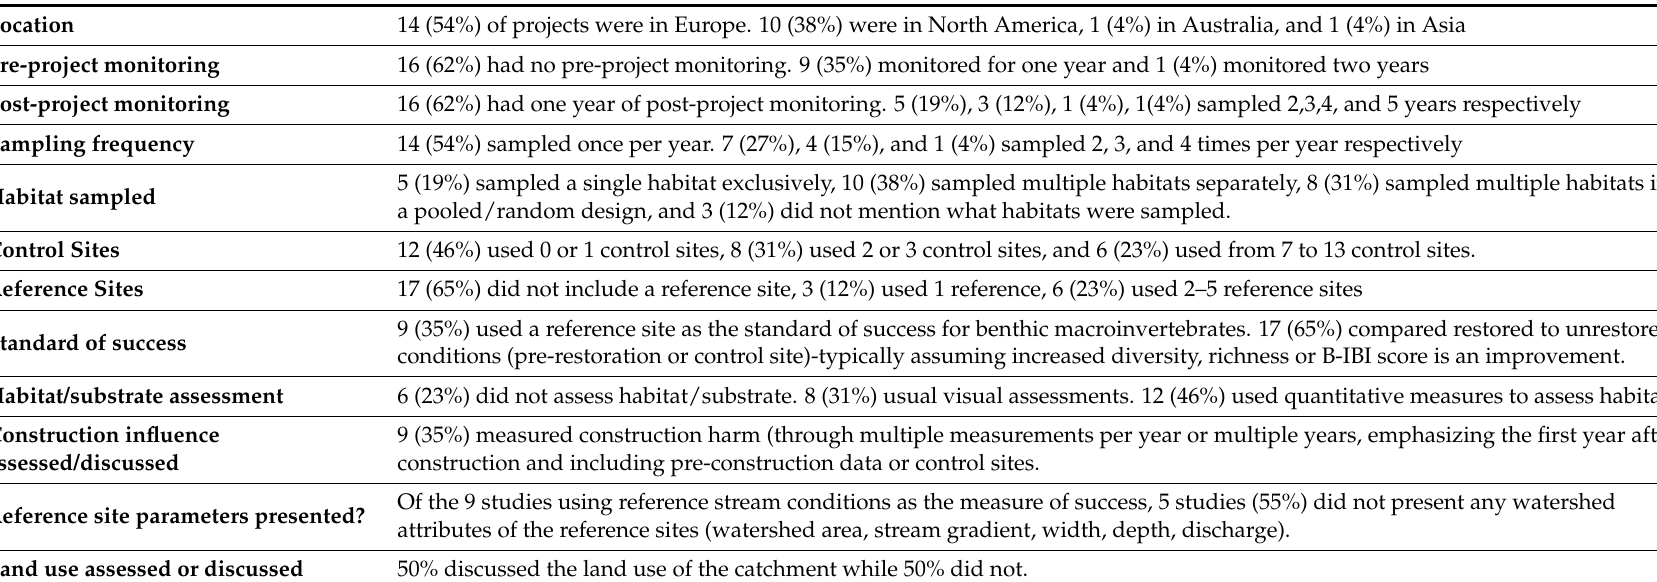
Table 2. Sampling design